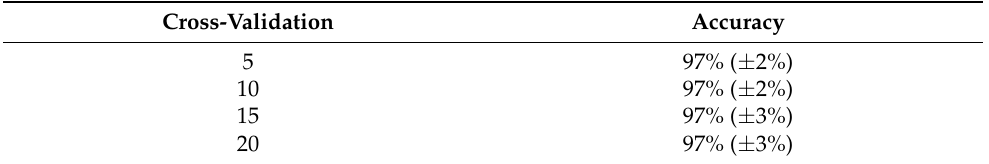
Table 7. Accuracy in the classification phase.